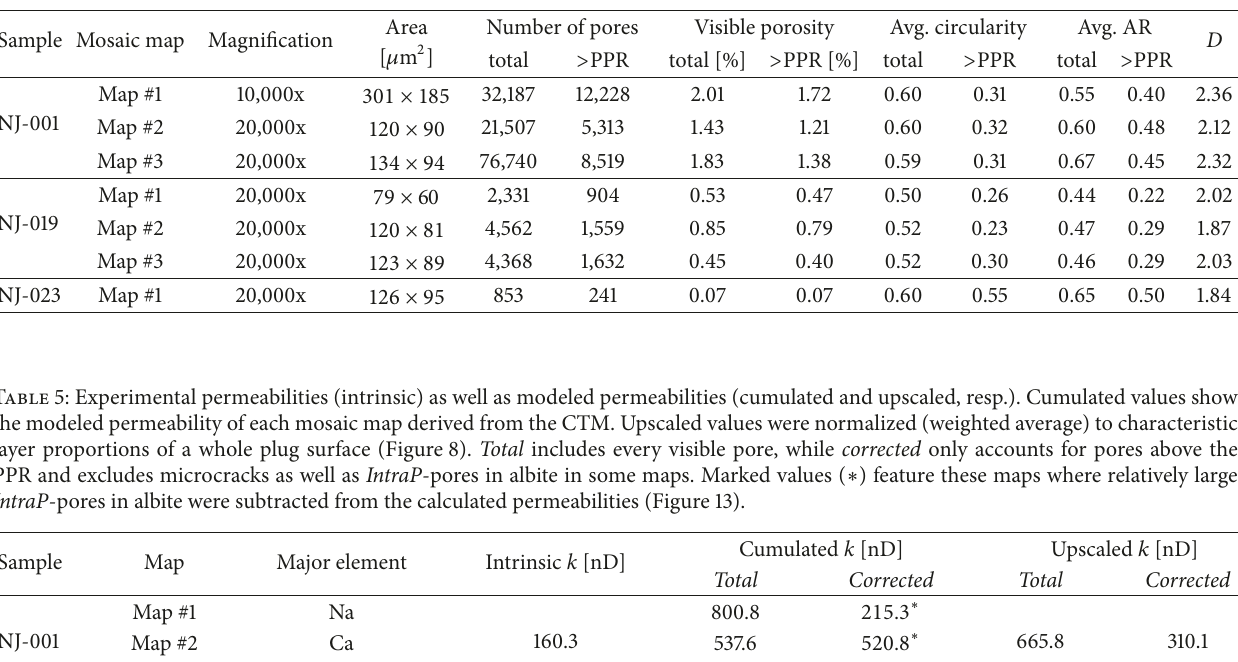
Table 4: Overview of parameters received through the pore shape analysis. All parameters excluding cracks (as well as the power law exponent) are also given above the practical pore resolution of 18 pixels (PPR).